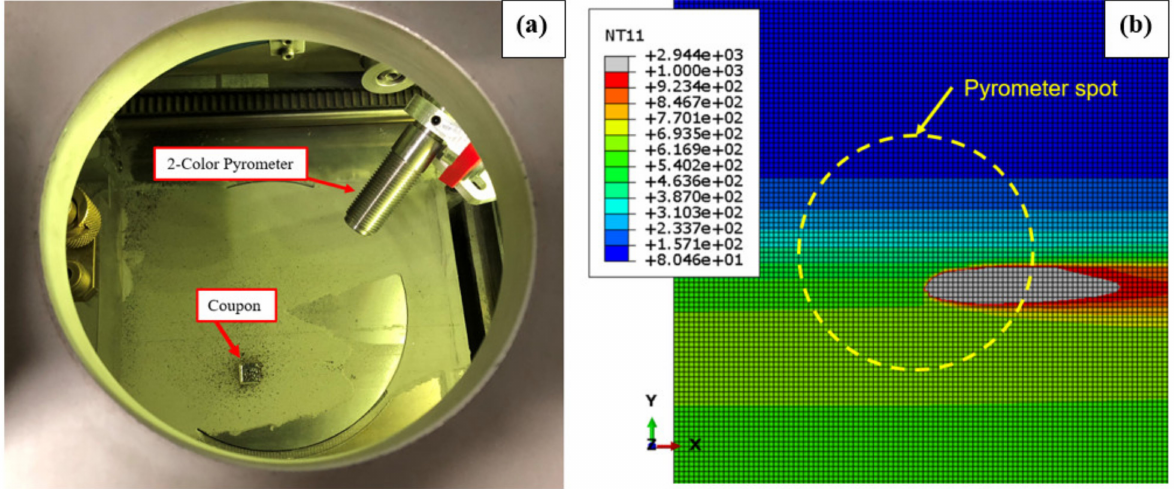
Figure 6. Pyrometer setup: ( a ) experimental; ( b )